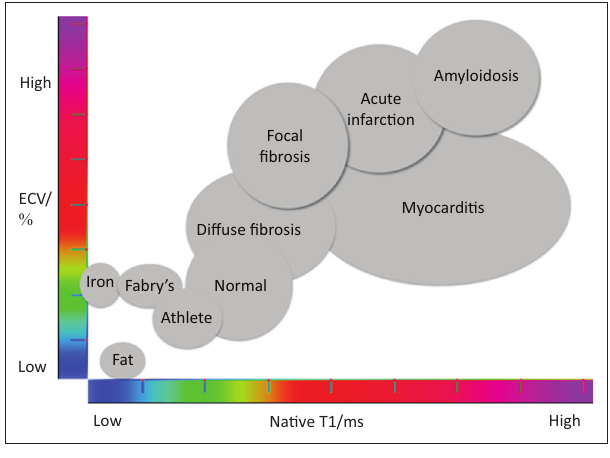
FIGURE 1: Extracellular volume fraction versus native T1 across a variety of conditions including physiological adaptation in